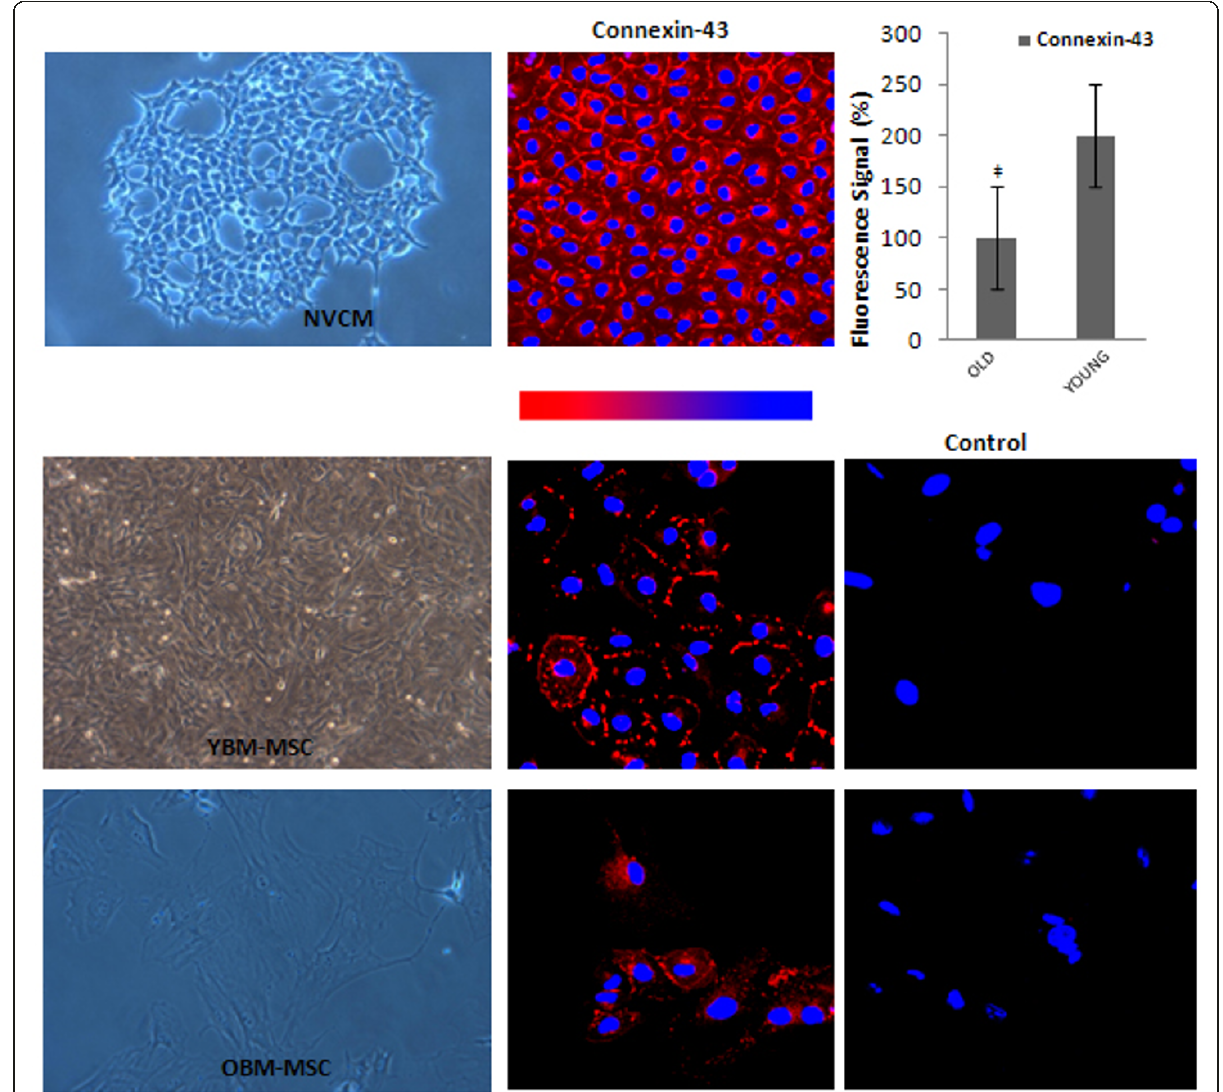
Figure 4 Immunocytochemical analysis of Connexin-43 staining: Representative images of anti-connexin-43 staining in cultured BM- MSCs from each experimental group . Columns show fluorescence signal intensity based on three independent differentiation experiments (n = 3) per animal. The ‘‡’ sign indicates a significant difference between the indicated group and any passage 3 groups from younger donors ( p < 0.05). Error bars designate means ±